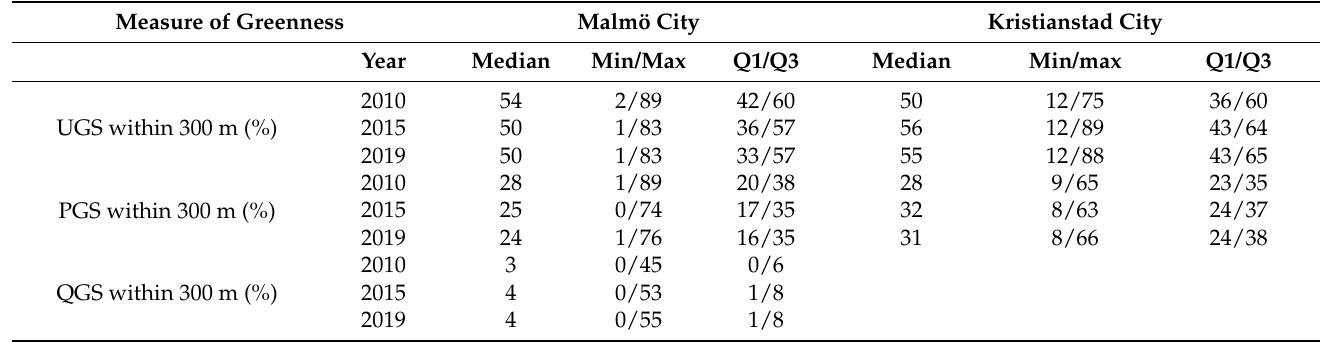
Table 4. Availability of urban green spaces (UGS), publicly available urban green space (PGS) and quiet publicly available urban green space (QGS) within 300 m from the residency for the study population in Malmö city ( n = 41702 in 2010, n = 43161 in 2015, and n = 45752 in 2019) and Kristianstad city ( n = 6522 in 2010, n = 7206 in 2015, and n = 7528 in 2019). Measure of Greenness Malmö City Kristianstad